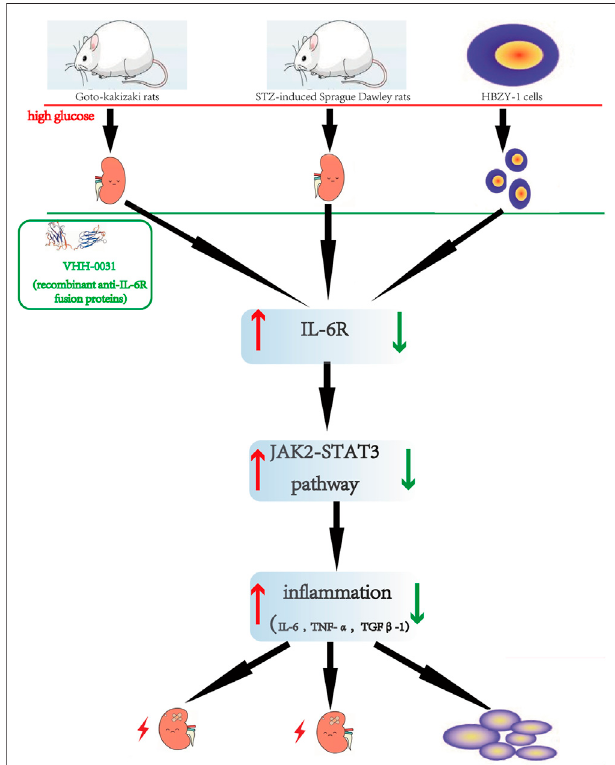
FIGURE 7 | The Flowchart describes renoprotective effect of the recombinant anti-IL-6R fusion proteins (VHH-0031) by inhibiting IL6R/JAK2/ STAT3 signaling pathway in diabetic nephropathy. The red of the fl owchart is express that the high glucose induces kidney injury and upregulates IL6R/JAK2/STAT3 signaling pathway. After treated by anti-IL-6R fusion proteins (VHH-0031) downregulates IL6R/JAK2/STAT3 signaling pathway. The above improvement results are re fl ected in